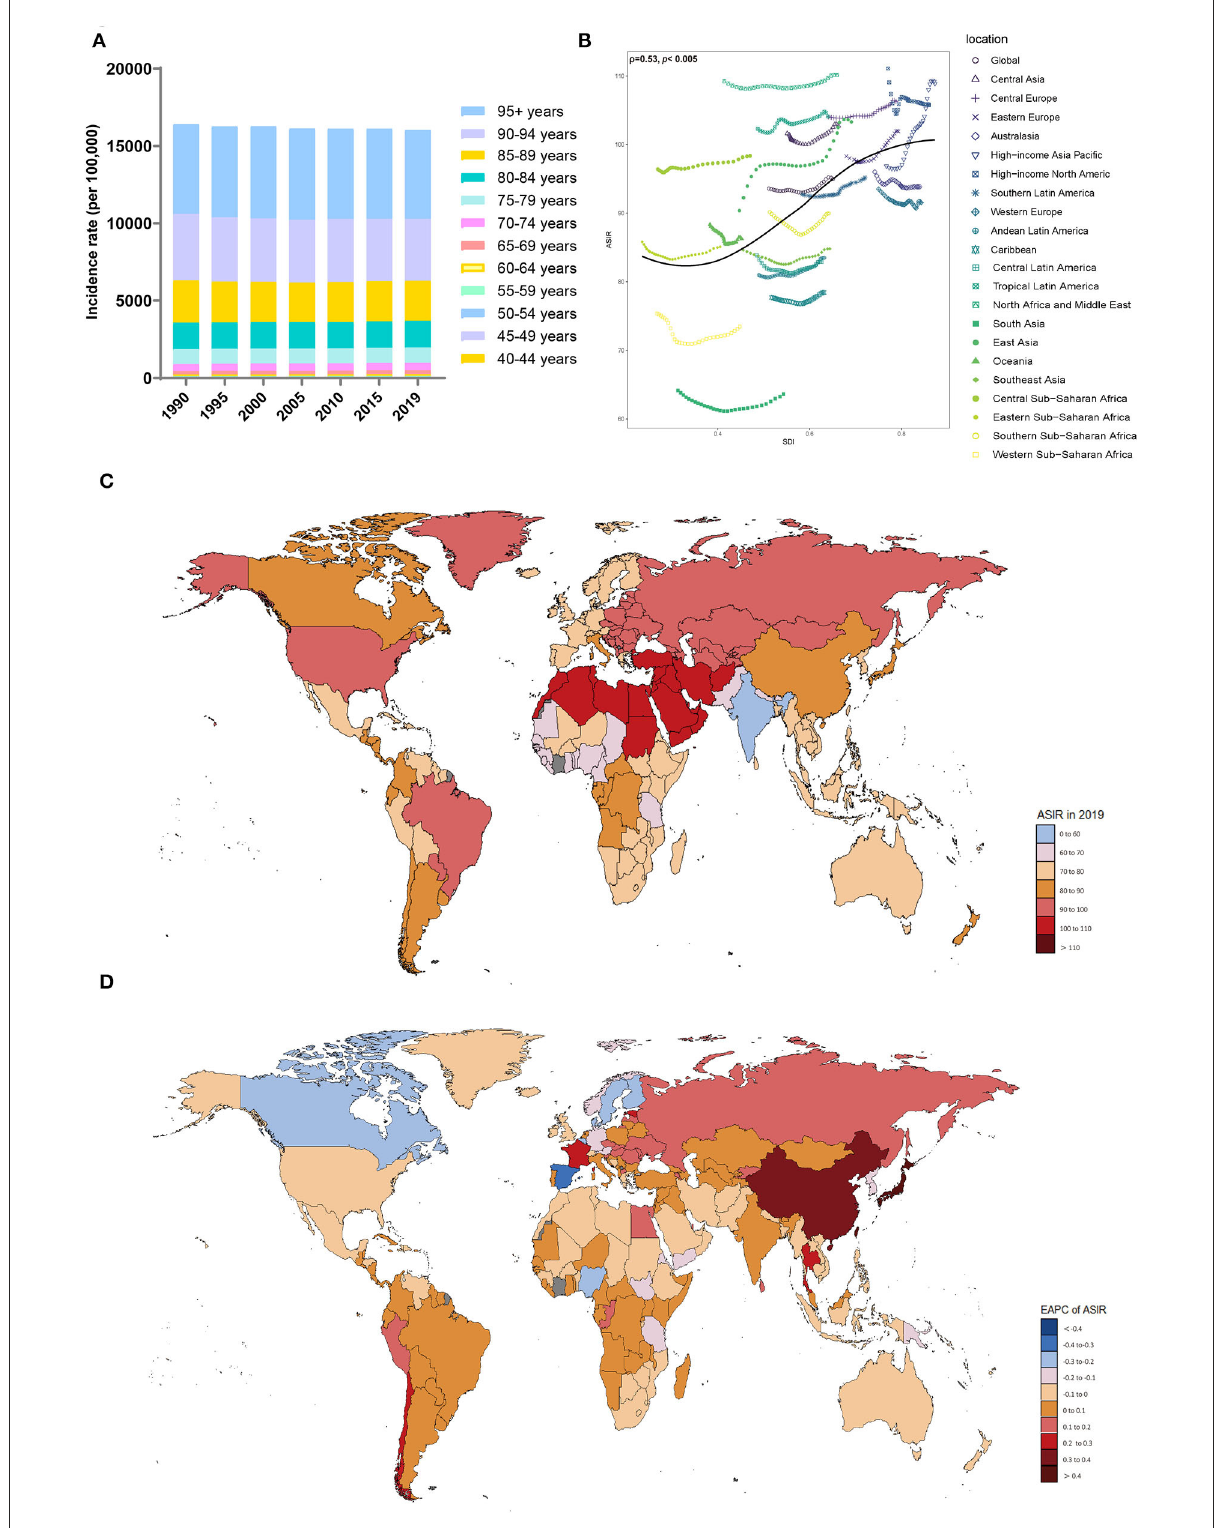
FIGURE1 Distribution of the incidence of Alzheimer’s disease and other dementias in 204 countries and territories from 1990 to 2019 by age group and SDI region. (A) Incidence rate in each age group. (B) Correlations between the ASIRs of Alzheimer’s disease and other